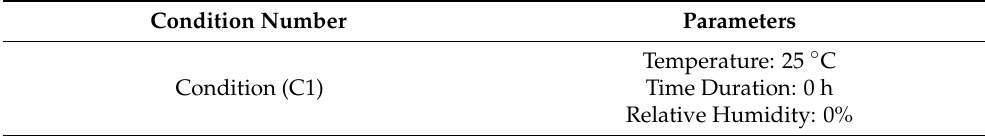
Figure 6. Different stages of hydrothermal testing ( a ) samples in the oven at 100 °C for 24 h, ( b , c ) samples immersed in distilled water ( d ) oven at 60 °C and ( e ) soaking time. Table 4. Hydrothermal Conditions.